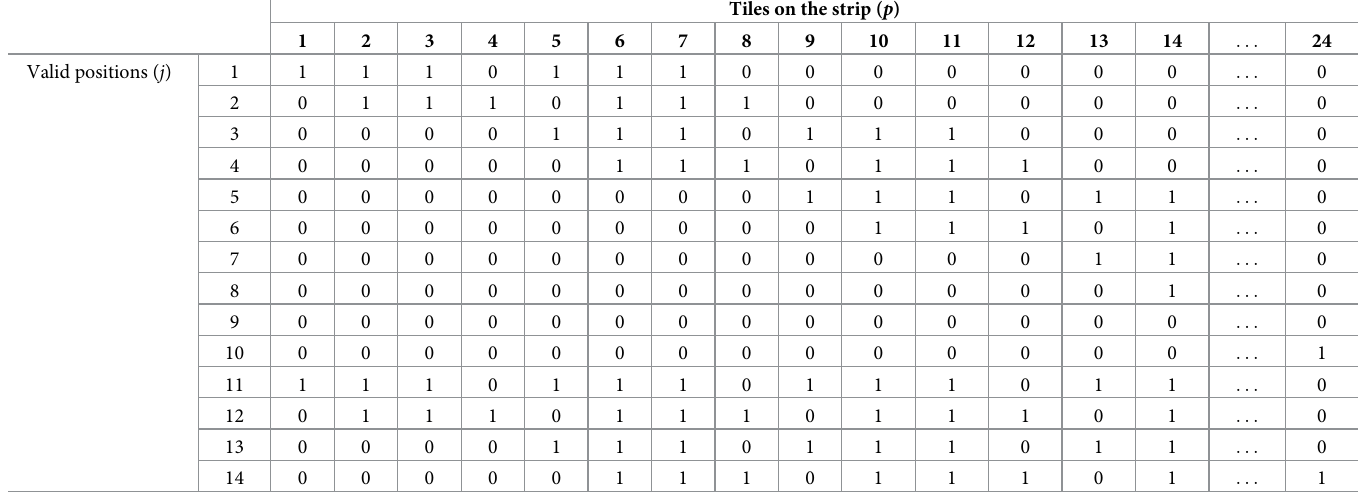
Table 1. Correspondence matrix C H for the set J H of two, one of 2 × 3 and the other of 5 × 3, in a strip with H = 6 and W = 4, corresponding to Fig